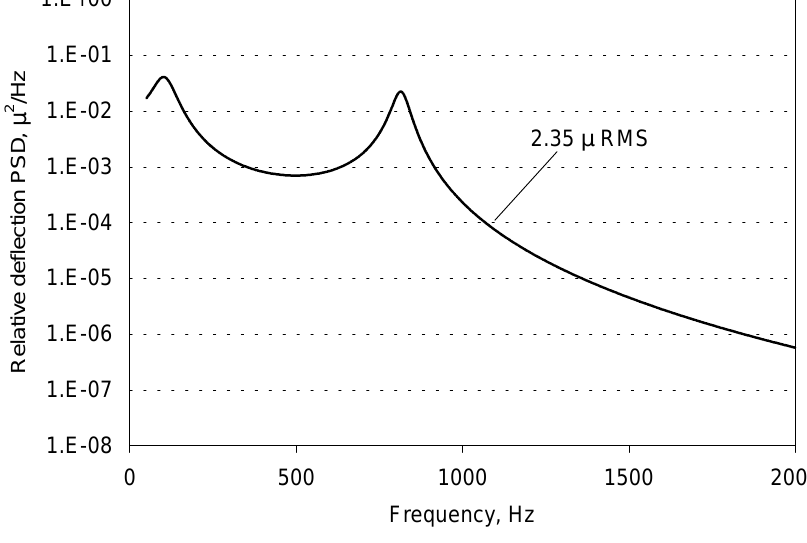
Fig. 12. Relative deflection of the vibration protected cold finger.